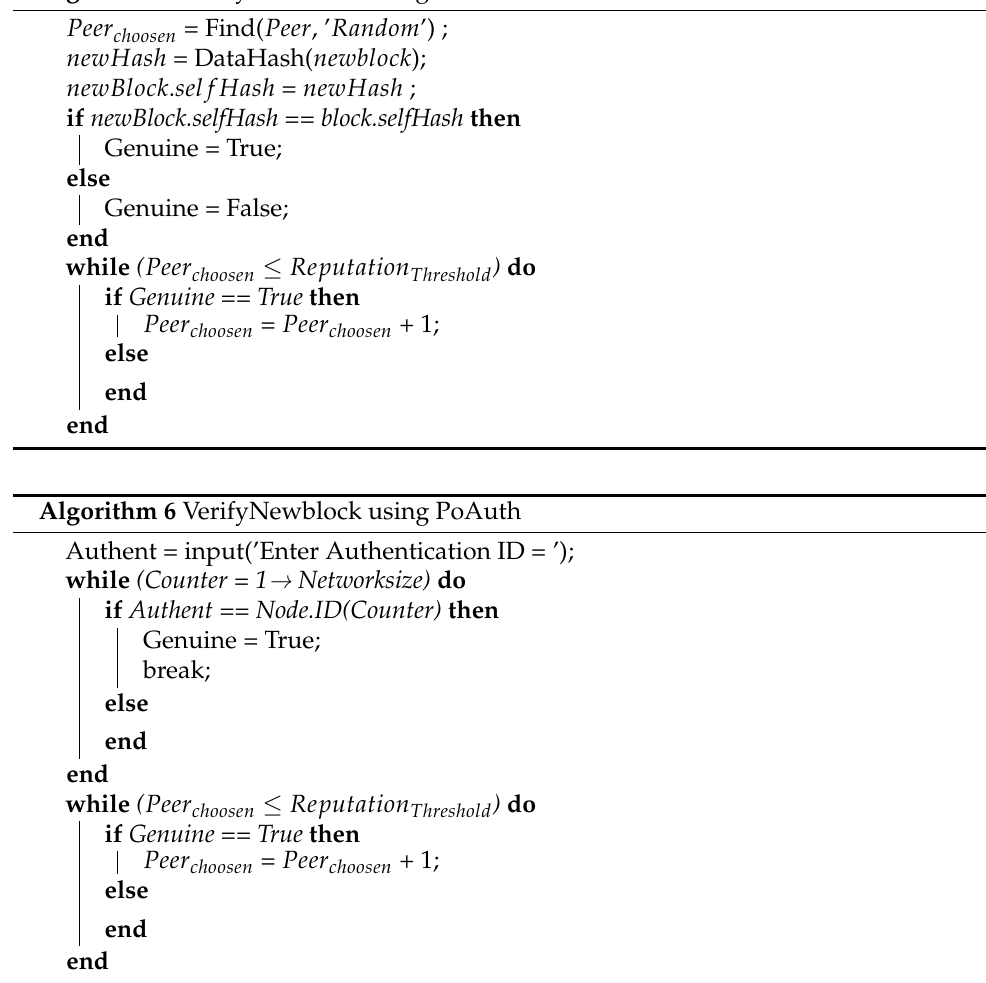
Algorithm 5 VerifyNewblock using PoA